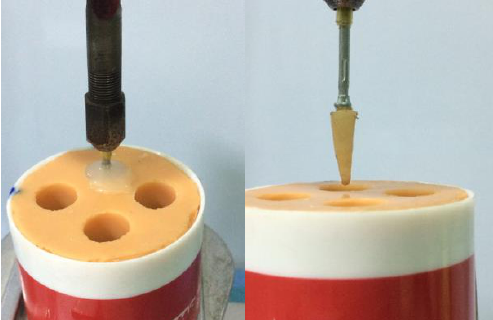
Figure 4: Central placement of the root with a cylinder hole